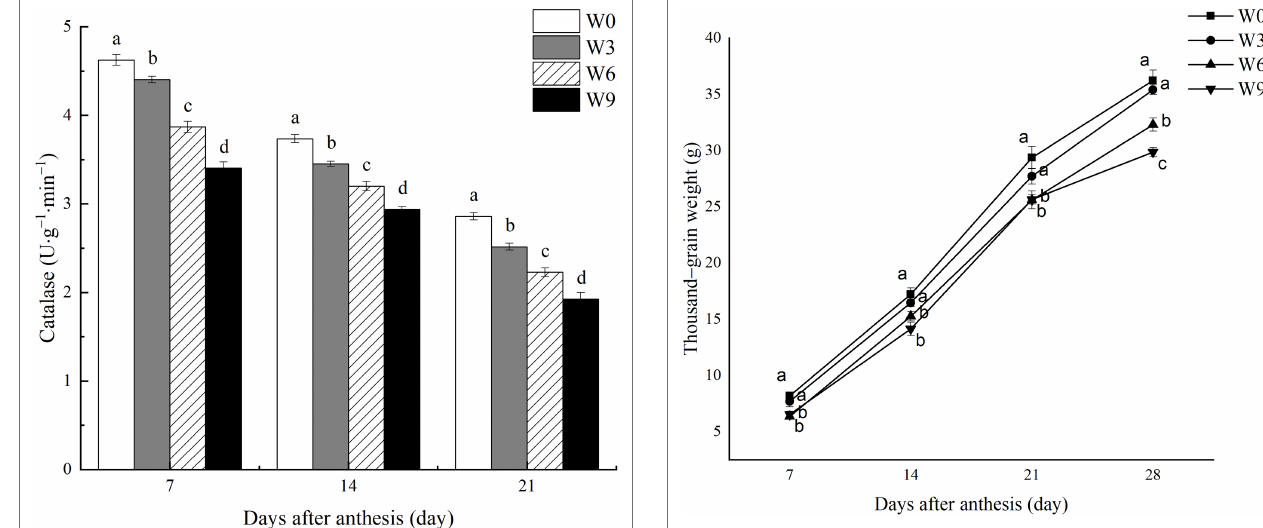
FIGURE 5 | CAT activity in wheat flag leaves under varying waterlogging durations. Data were collected at 7, 14, and 21 days after anthesis. W0 = control, W3 = 3 days of waterlogging, W6 = 6 days of waterlogging, W9 = 9 days of waterlogging. Vertical bars represent the mean of each treatment (six replicates across two years) ± SE (standard errors). Means carrying the same letter are not significantly different at the 5% level.